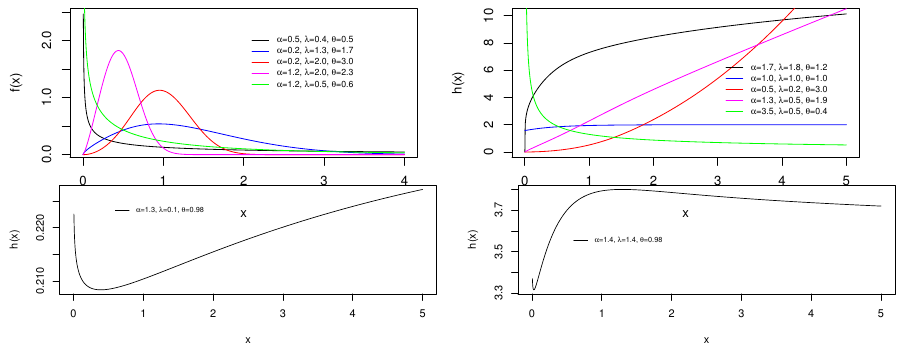
Figure 1. Plots of the pdf and hrf of the ECSW distribution for some parameter